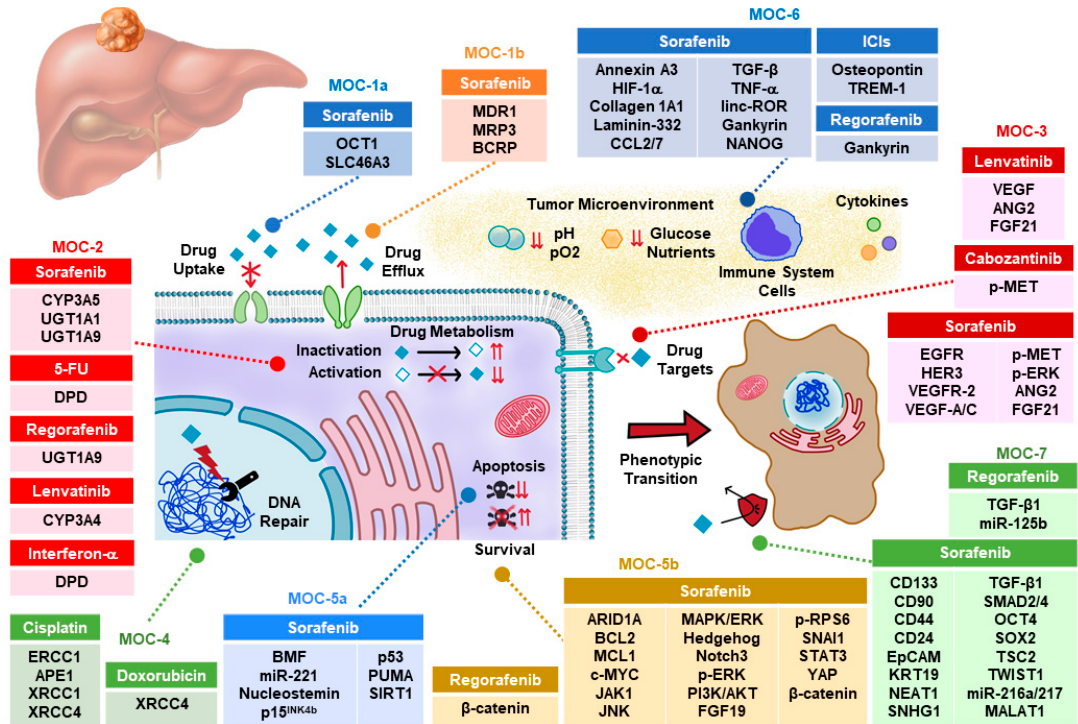
Figure 1. Proteins and non-coding RNAs accounting for chemoresistance in hepatocellular carcinoma. ICI, immune checkpoint inhibitors; MOC, mechanism of chemoresistance.